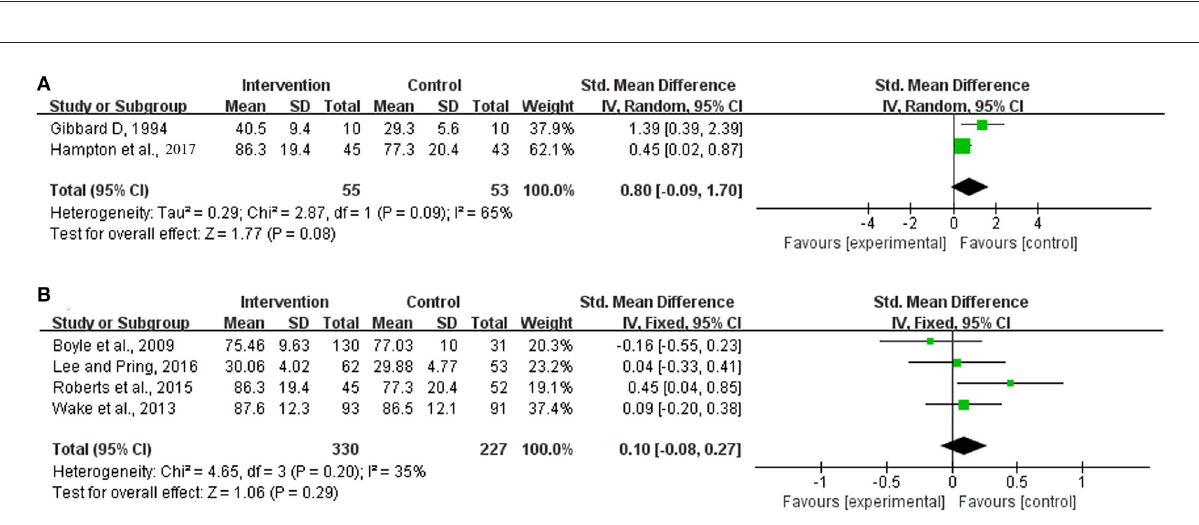
FIGURE6 Meta-analysis outcomes of the effect of the parent-guided intervention and non-parent-guided intervention on overall receptive language development. (A) Parent-guided intervention; (B) Non-parent-guided intervention. Control, no or delayed